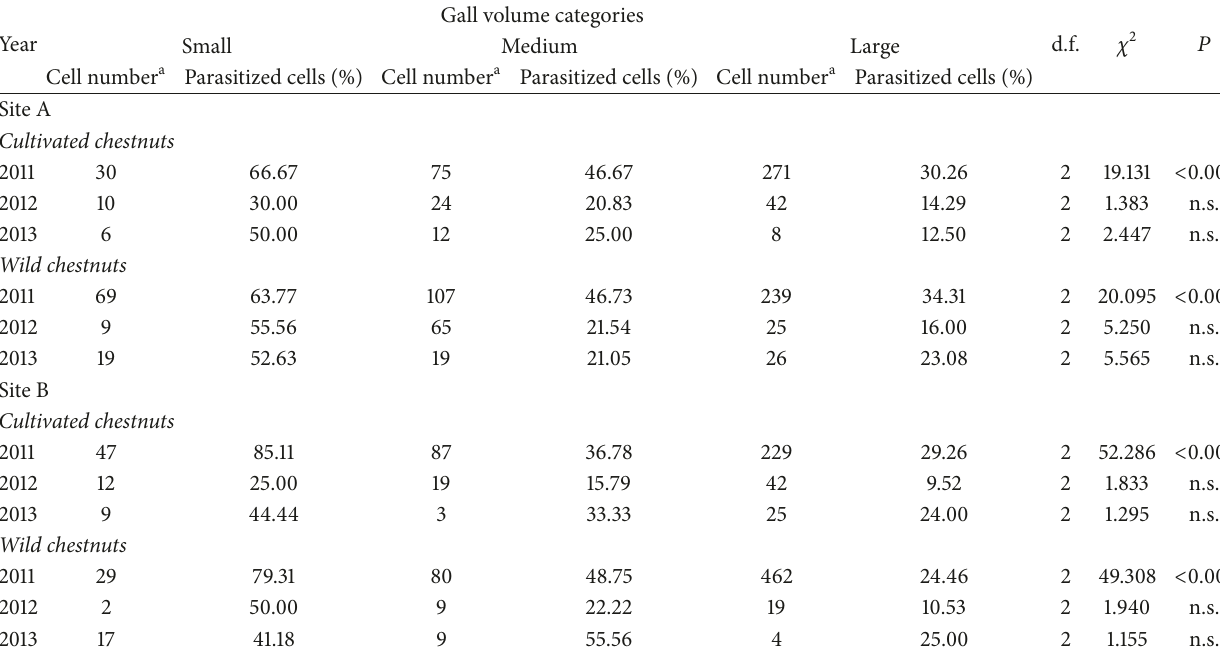
Table 4: Parasitized cells within Dryocosmus kuriphilus galls collected from cultivated and wild chestnuts in the two study sites (site A = 478 m a.s.l.; site B = 665 m a.s.l.) at Marradi (Italy) sorted by volume categories (small = 0.02–0.064 cm 3 ; medium = 0.065–1.31cm 3 ; large